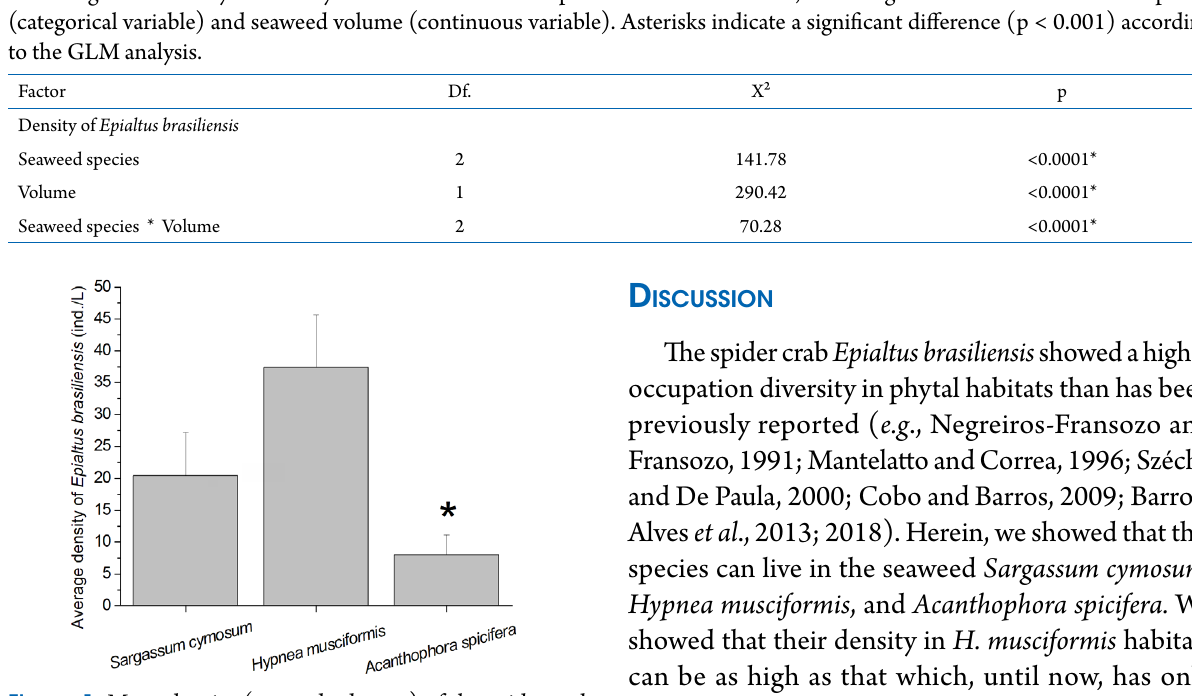
Figure 1. Mean density (± standard error) of the spider crab Epialtus brasiliensis among the seaweed Sargassum cymosum, Hypnea musciformis and Acanthophora spicifera . Asterisks indicate a significant difference (p < 0.005) according to the GLM analysis, in which the average density of the spider crabs was compared between the seaweed species, which were considered to influence the seaweed